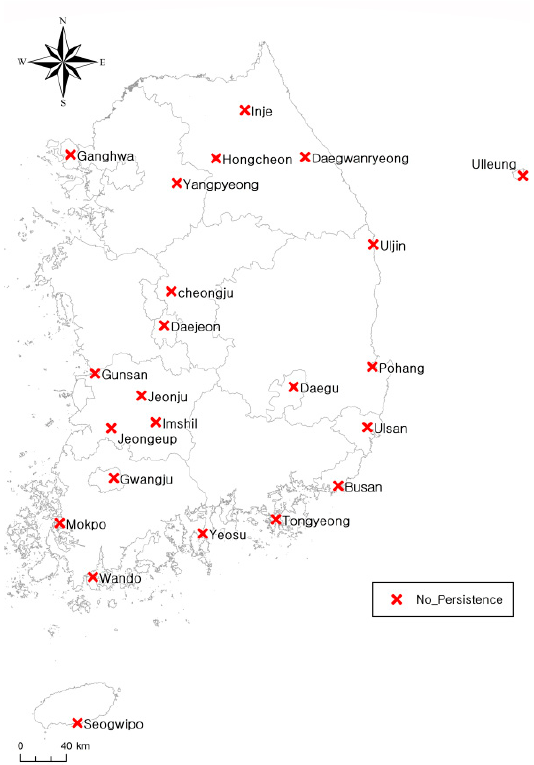
Figure 16. Persistence analysis results using the climate change scenarios.